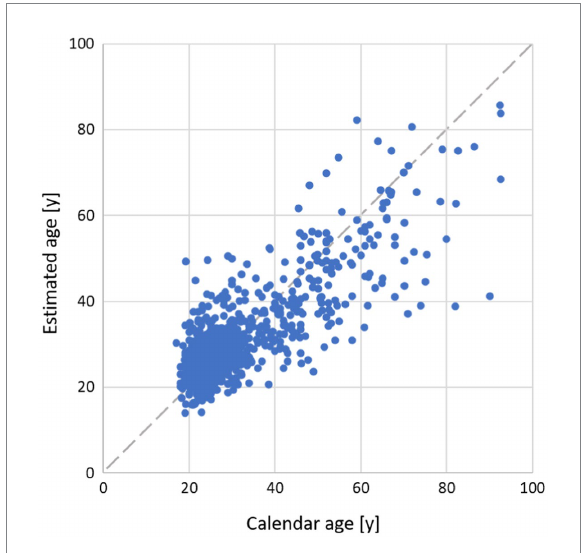
FIGURE 2 Relation of individual age estimated by GPR and calendar age. Dashed gray line indicates perfect concordance.